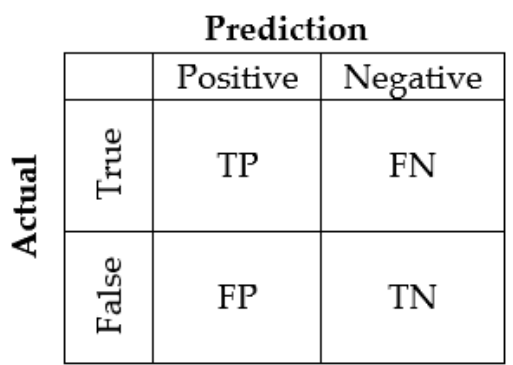
Figure 11. In the confusion matrix, T / F indicates the right or wrong prediction, and P / N indicates the result of prediction. Prediction represents the predicted value, which is equivalent to the result of the test set (with possibly wrong results), and actual represents the real label (equivalent to the ground